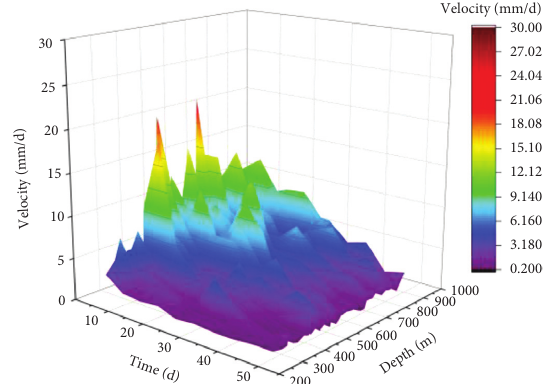
Figure 7: Deformation velocity of roof to floor.